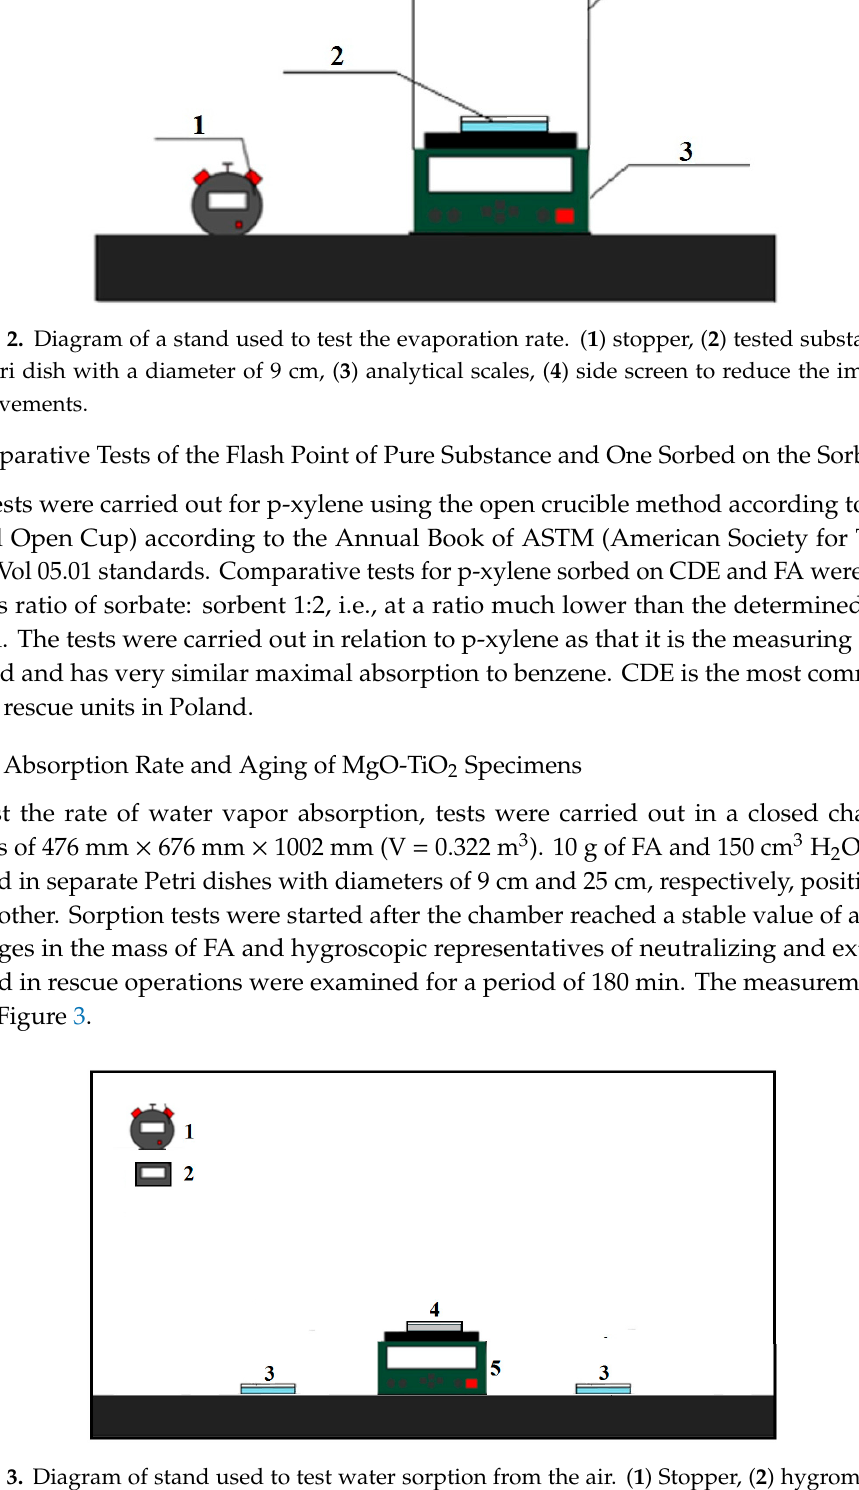
Figure 3. Diagram of stand used to test water sorption from the air. ( 1 ) Stopper, ( 2 ) hygrometer, ( 3 ) Petri dishes with evaporating water, ( 4 ) sorbent, ( 5 ) analytic scales. Closed chamber with dimensions of 476 mm × 676 mm × 1002 mm (V = 0.322 m 3 ).